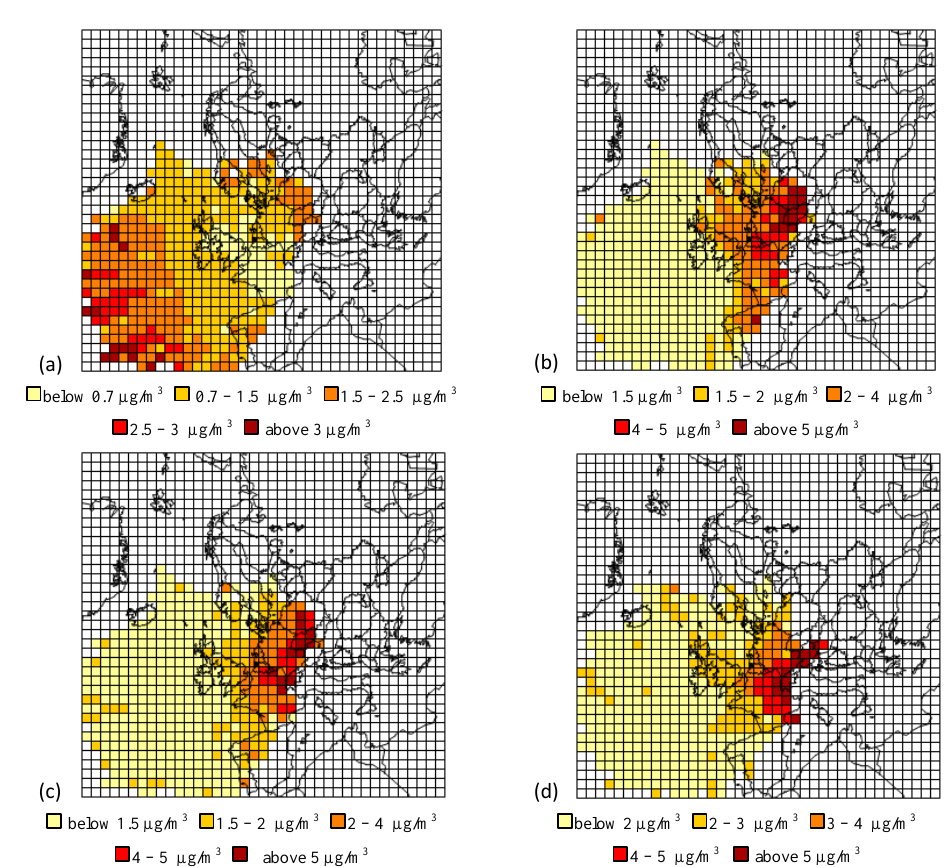
Fig. 3. Concentration field map of (a) particulate chloride; (b) particulate nitrate (c) sulphate (d) particulate OC.